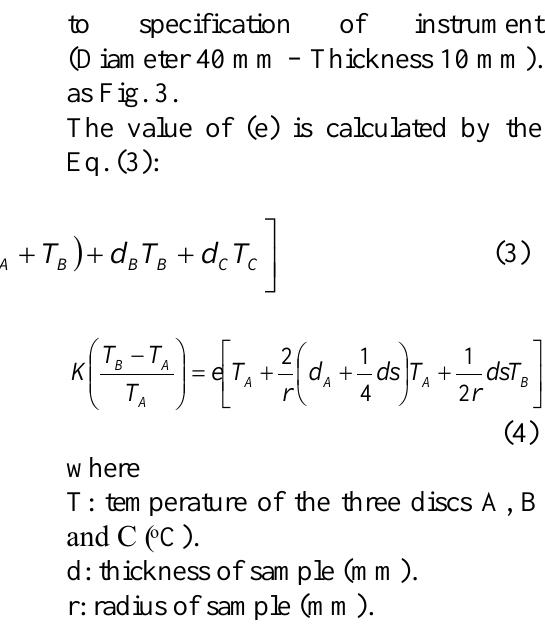
Fig. 2: Flexural strength samples before